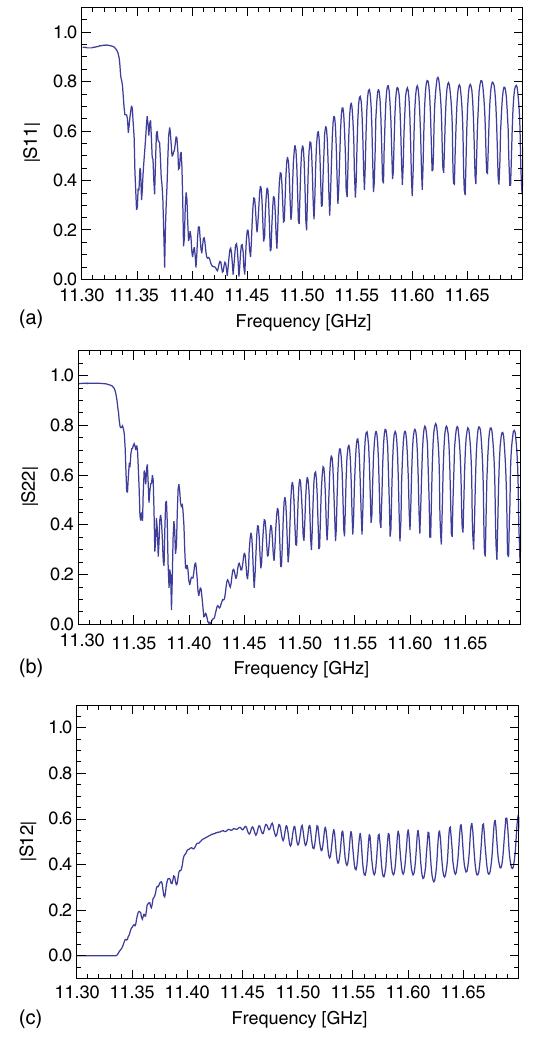
FIG. 10. Measurements of the deflector rf scattering parameters vs frequency: (a) magnitude of the reflection from input coupler with value at operating frequency of 0.03; (b) magnitude of the reflection from input coupler with value at operating frequency of 0.04; (c) magnitude of the transmission through the deflector with value at operating frequency of